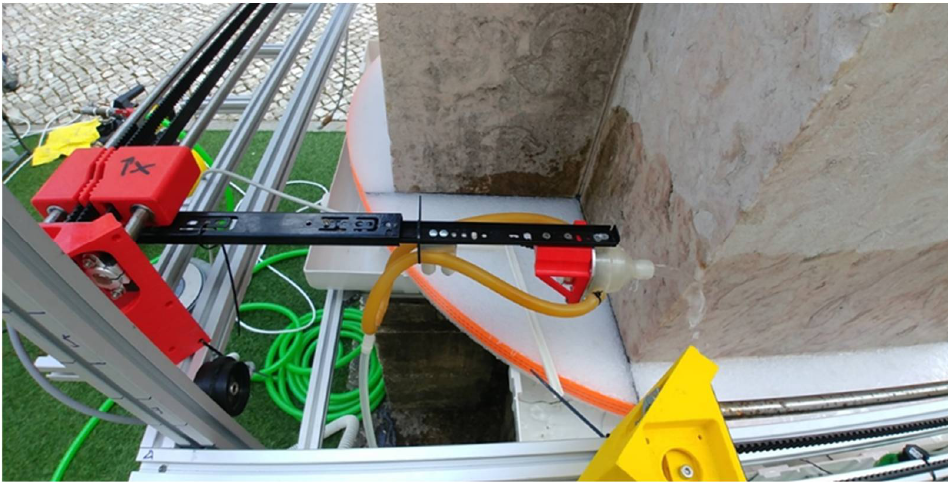
Figure 12. Zoom of the system expelling the waterjet from the pipes to the nozzles and inspecting the base of the column.